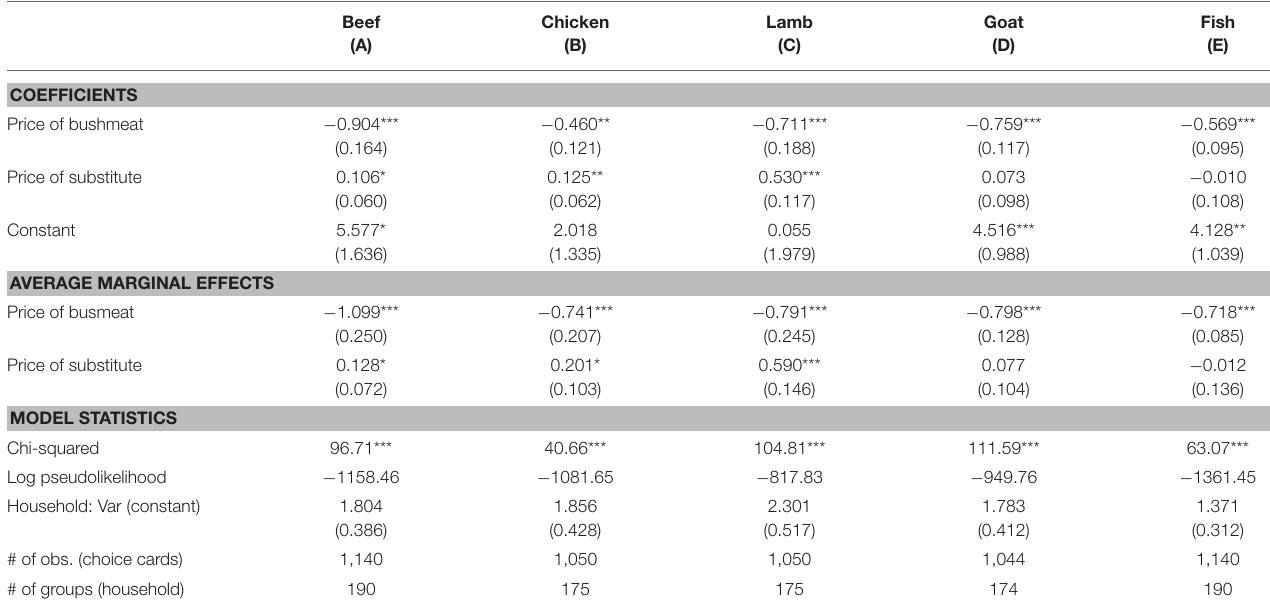
TABLE 3 | Coefficients of the simple mixed effect Poisson models representing the own and cross-price elasticities of bushmeat demand for individual substitute meat